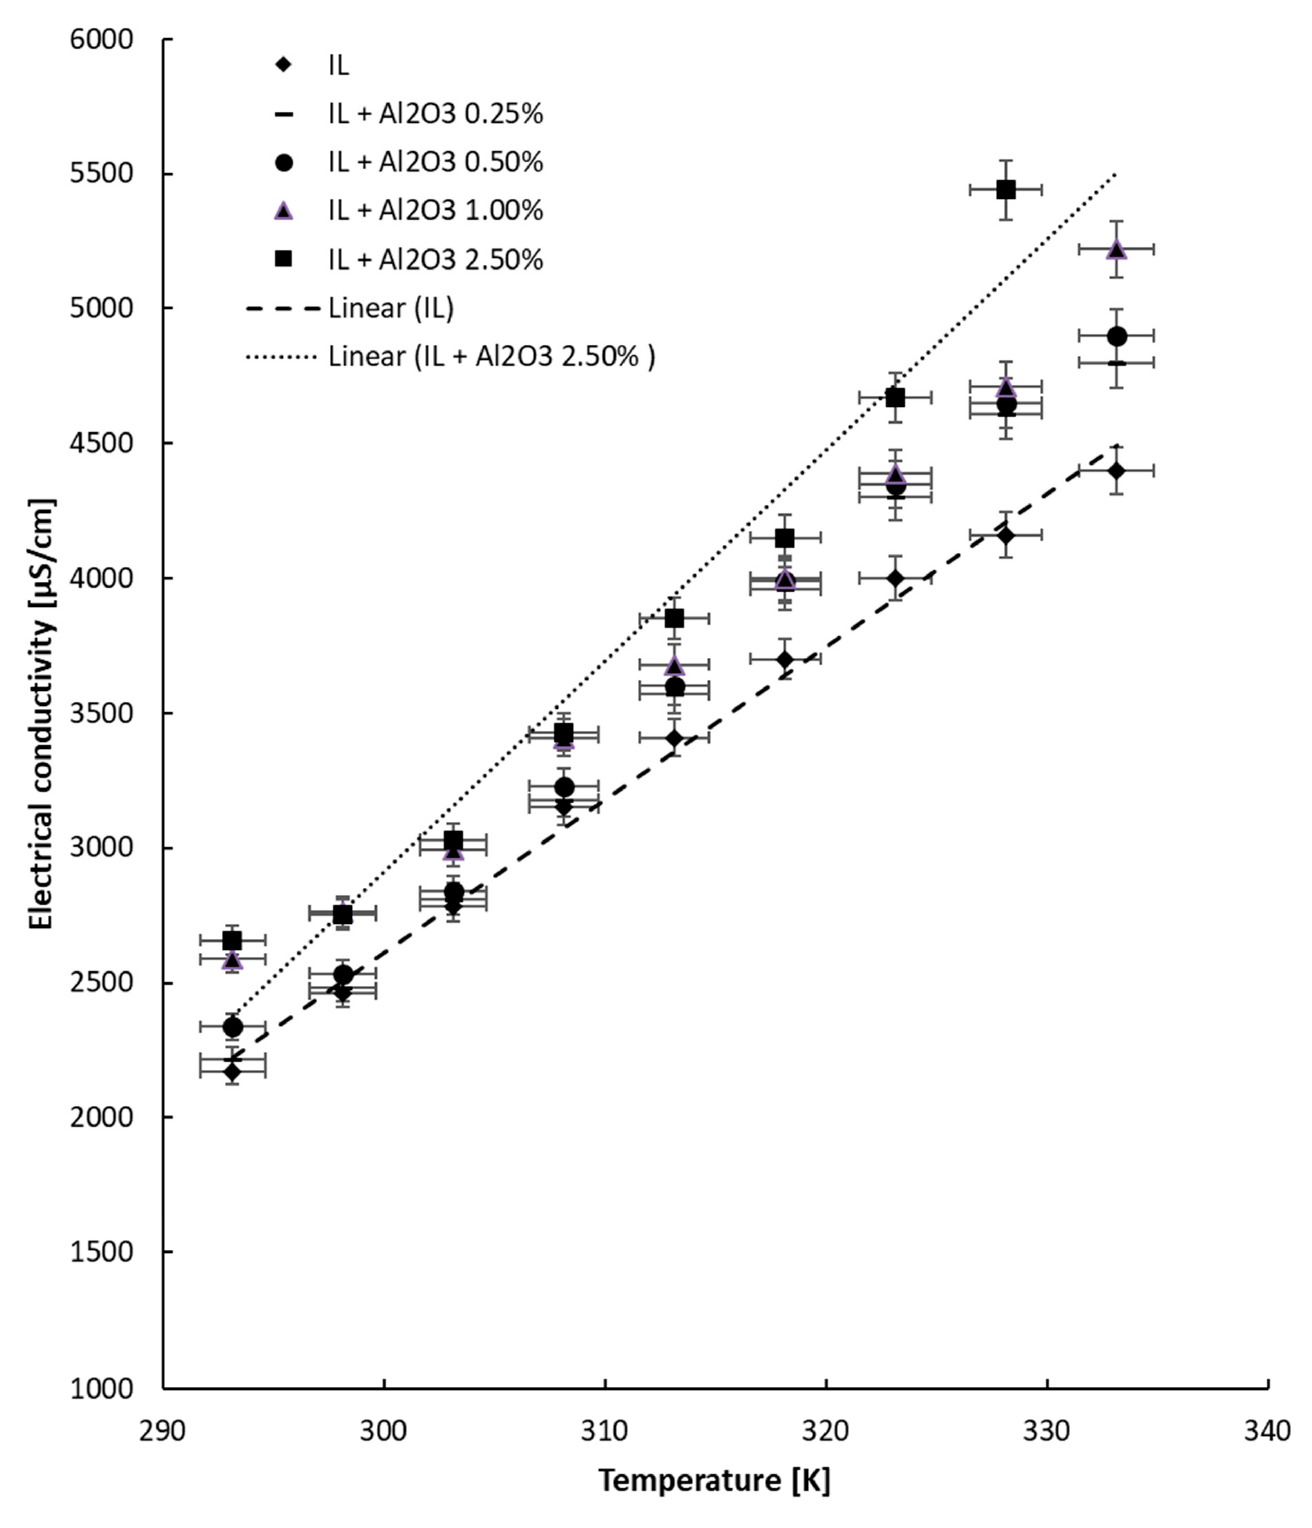
Figure 4. Experimental results for electrical conductivity variation with temperature: IL and Al 2 O 3 + IL samples.